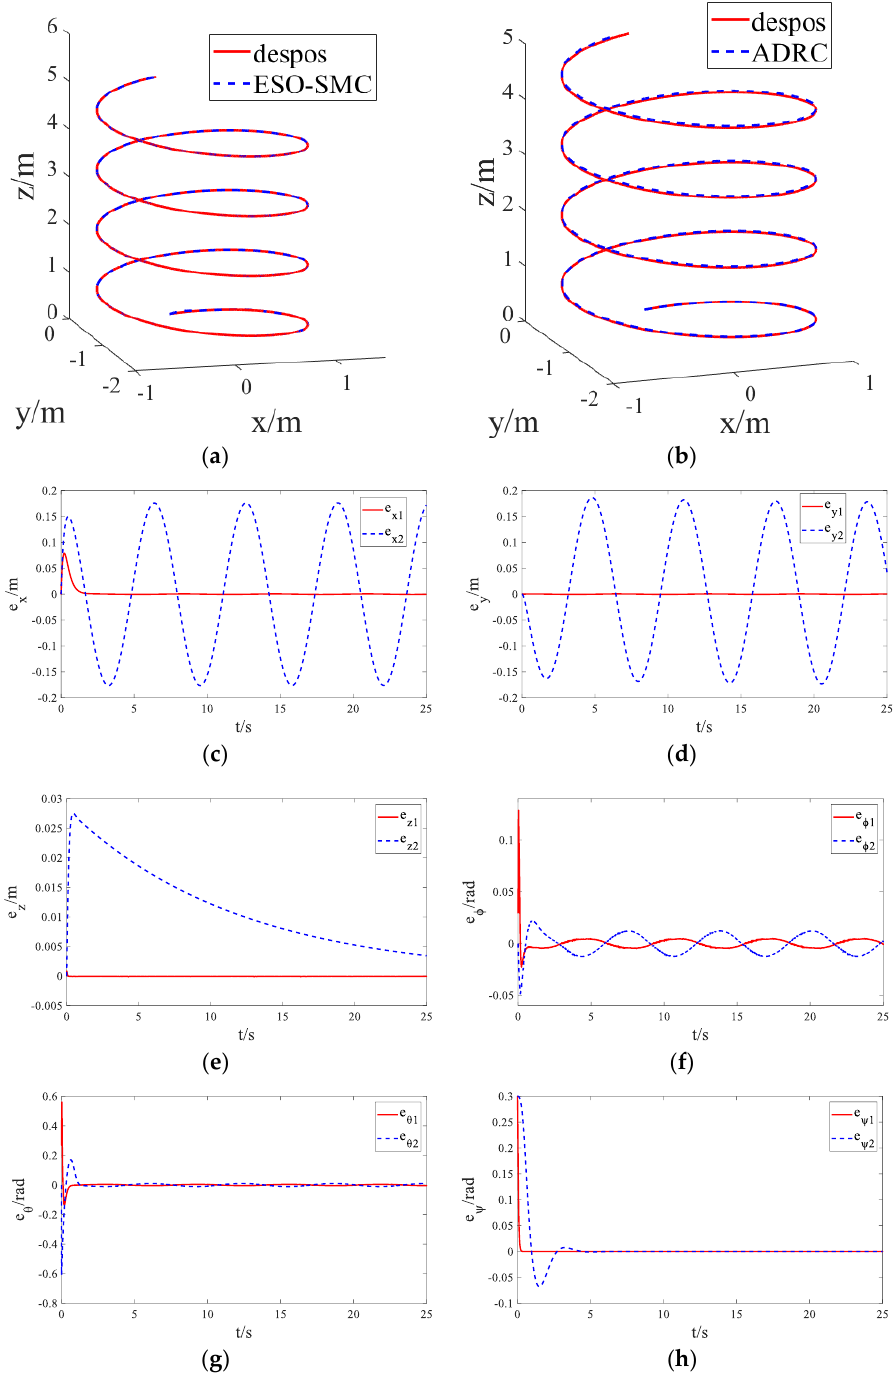
Figure 5. Comparison of the trajectory − tracking errors based on ESO − SMC and ADRC without disturbance: ( a ) ESO − SMC 3D effect; ( b ) ADRC 3D effect; ( c ) x trajectory; ( d ) y trajectory; ( e ) z trajectory; ( f ) roll angle; ( g ) pitch angle; and ( h ) yaw angle.